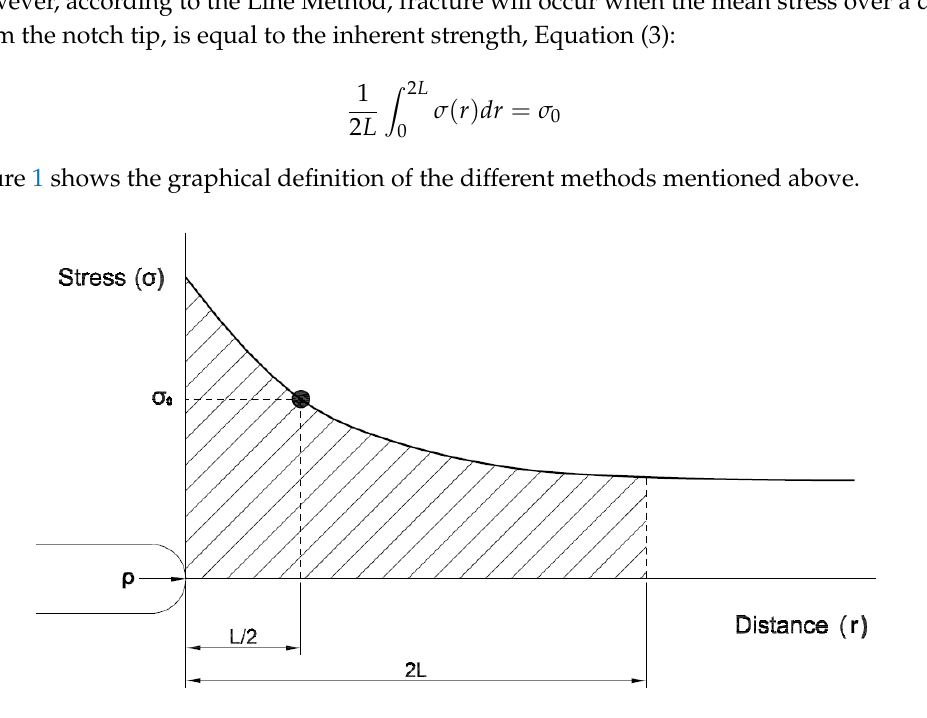
Figure 1. Graphical definition of the Pont Method (PM) and the Line Method (LM).